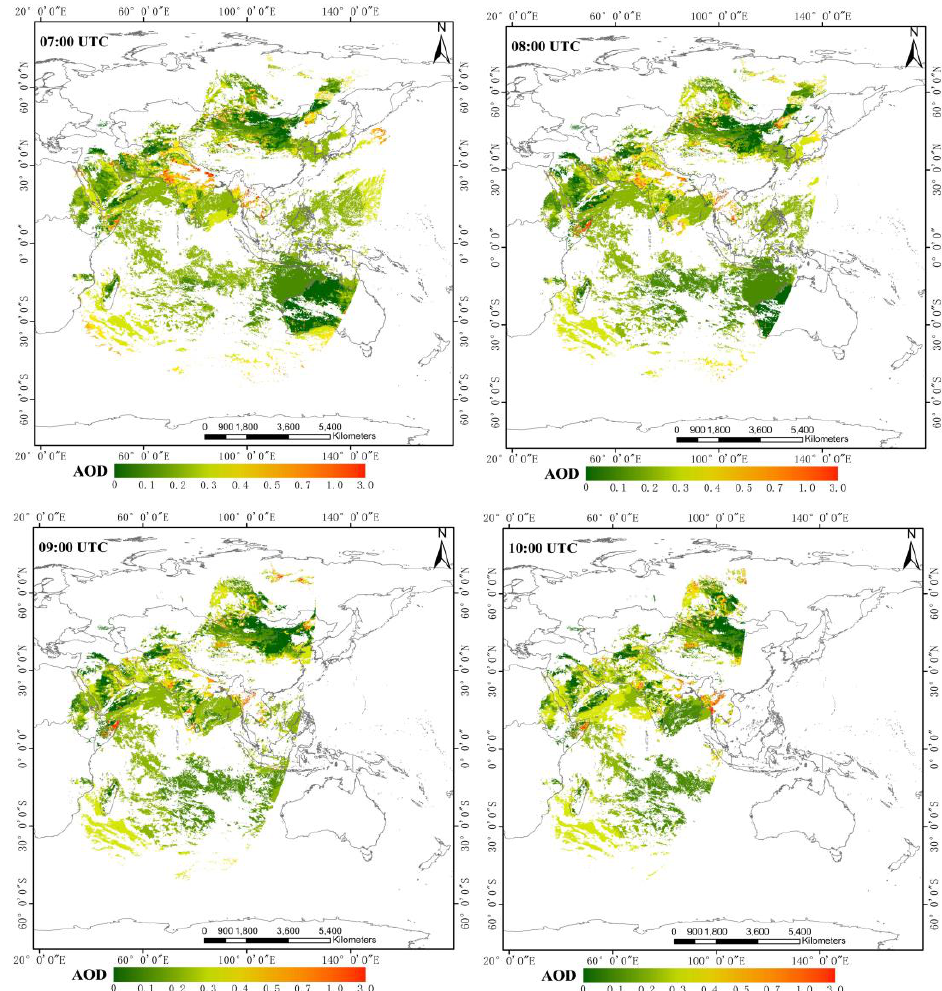
Figure 9. Hourly averaged spatial distributions of the AOD retrieved from FY-4A/AGRI data over the full disk using the NNAeroG algorithm, for each hour from 03:00 to 10:00 (UTC) on 23 April 2020. At 04:00 UTC, the area in the red dashed with dot is South Asia. At 05:00 UTC, the area in the red dashed is the land – sea boundary area in northwest Australia.